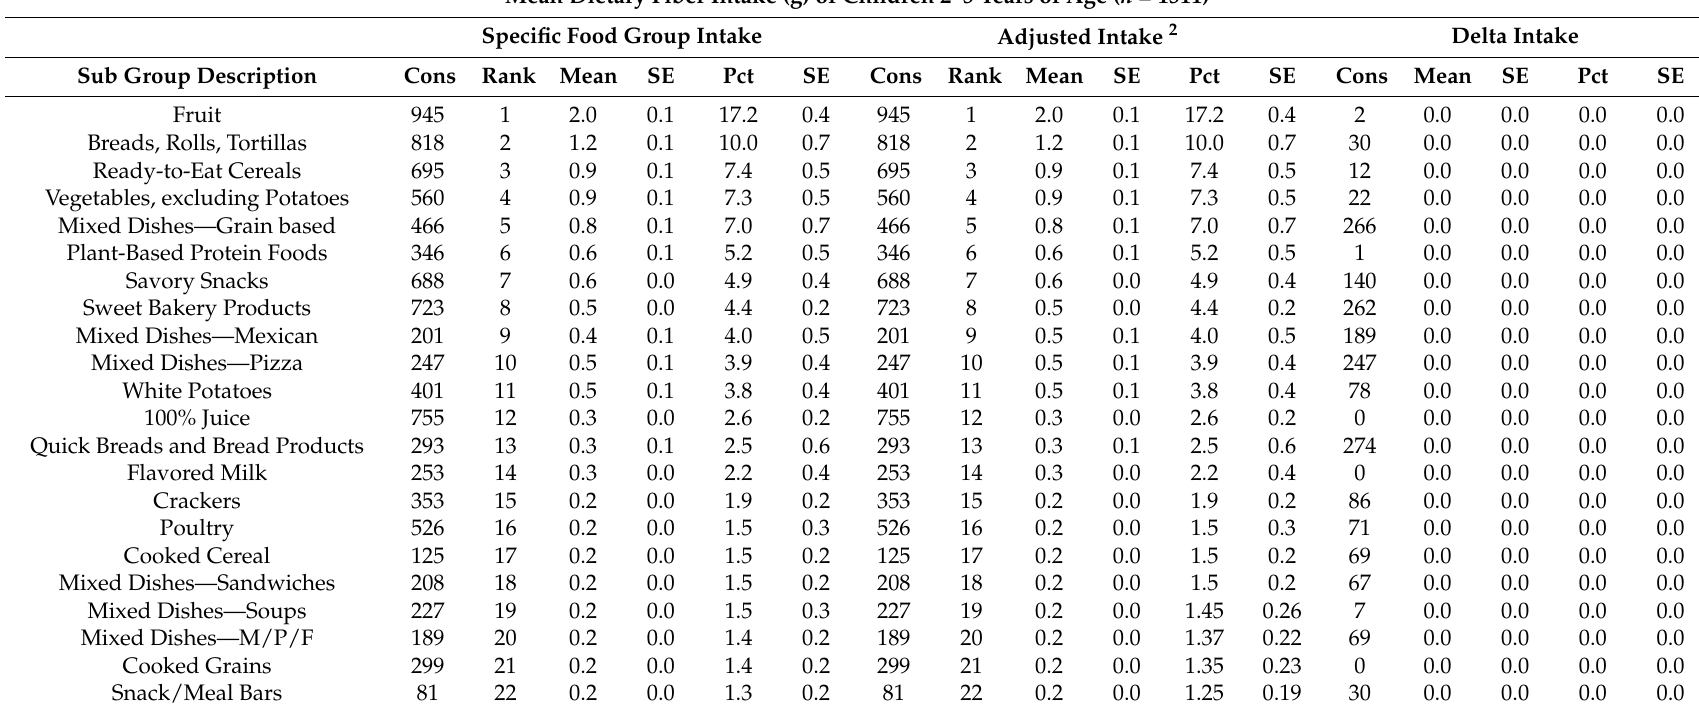
Table 2. Food/food group sources 1 of mean dietary fiber (g) intake among US children aged 2–18 years ( N = 5876): National Health and Nutrition Examination Survey